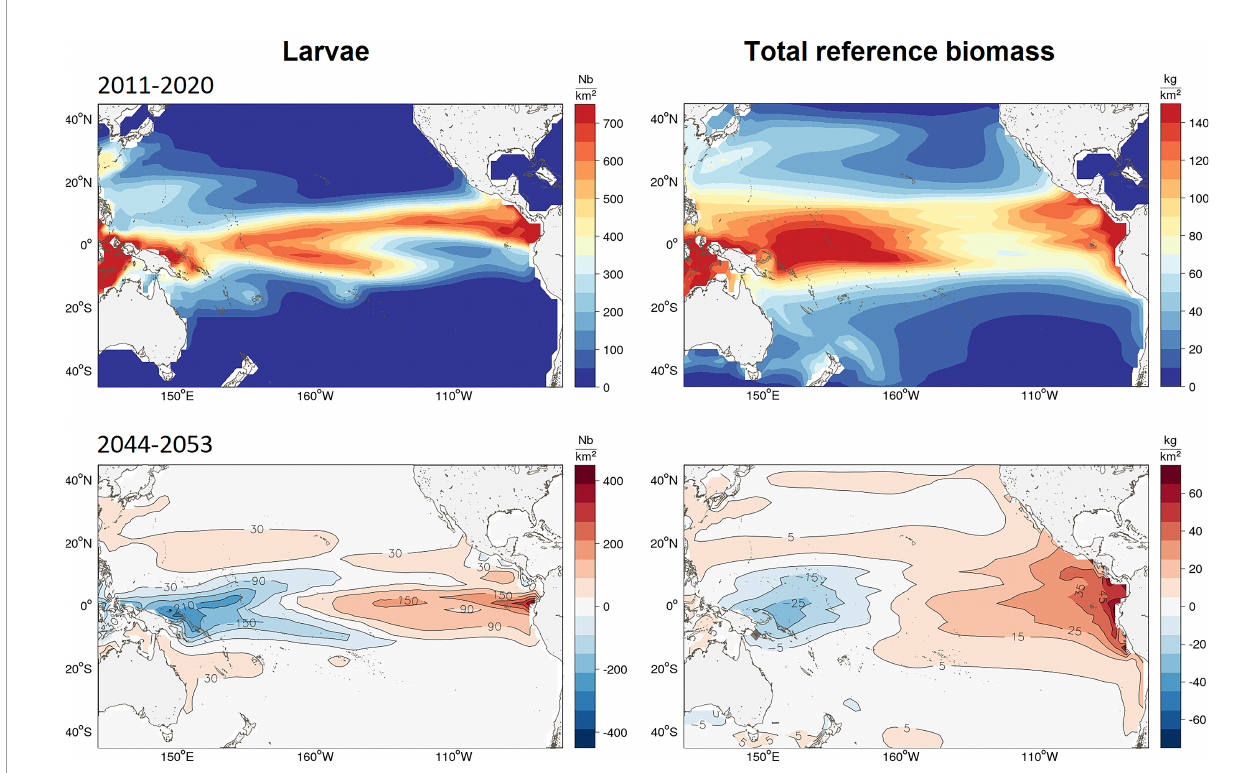
FIGURE 3 | Maps of average distribution from the ensemble simulation of (top-left) yellow fi n larvae in Nb/sq. km and (top-right) total unexploited (without fi shing) biomass (top-right) in mt/sq.km predicted by SEAPODYM in 2001-10. The color maps for 2050 (2044-53) show the average biomass change since 2015 (in respective density units) projected to occur under the high emissions scenario